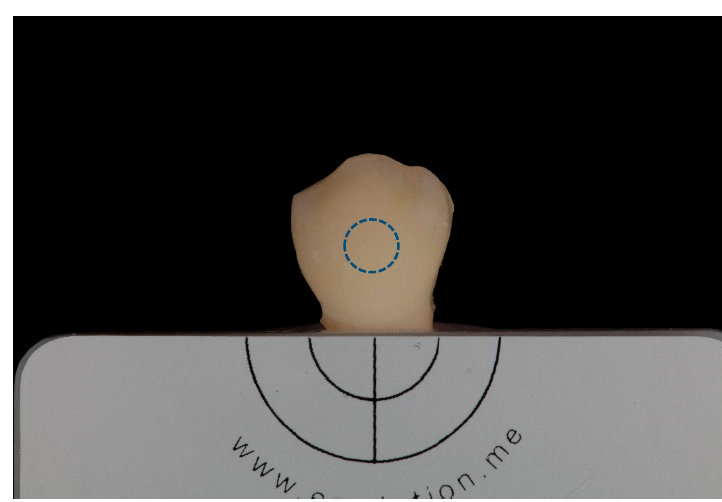
Figure 2. Positioning device for photographic record. The blue dashed line delimits the total area considered for shade analysis within the Commission International de l’Eclairage (CIE) L* a* b* color space for all timeframes.